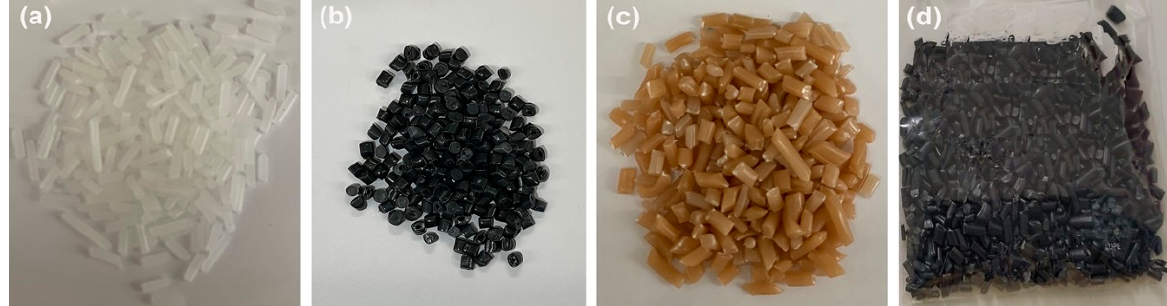
Figure 2. Images of samples ( a ) HDPE, ( b ) rHDPE, ( c ) HDPE–Cu-CPs, and ( d ) rHDPE–Cu-CPs.